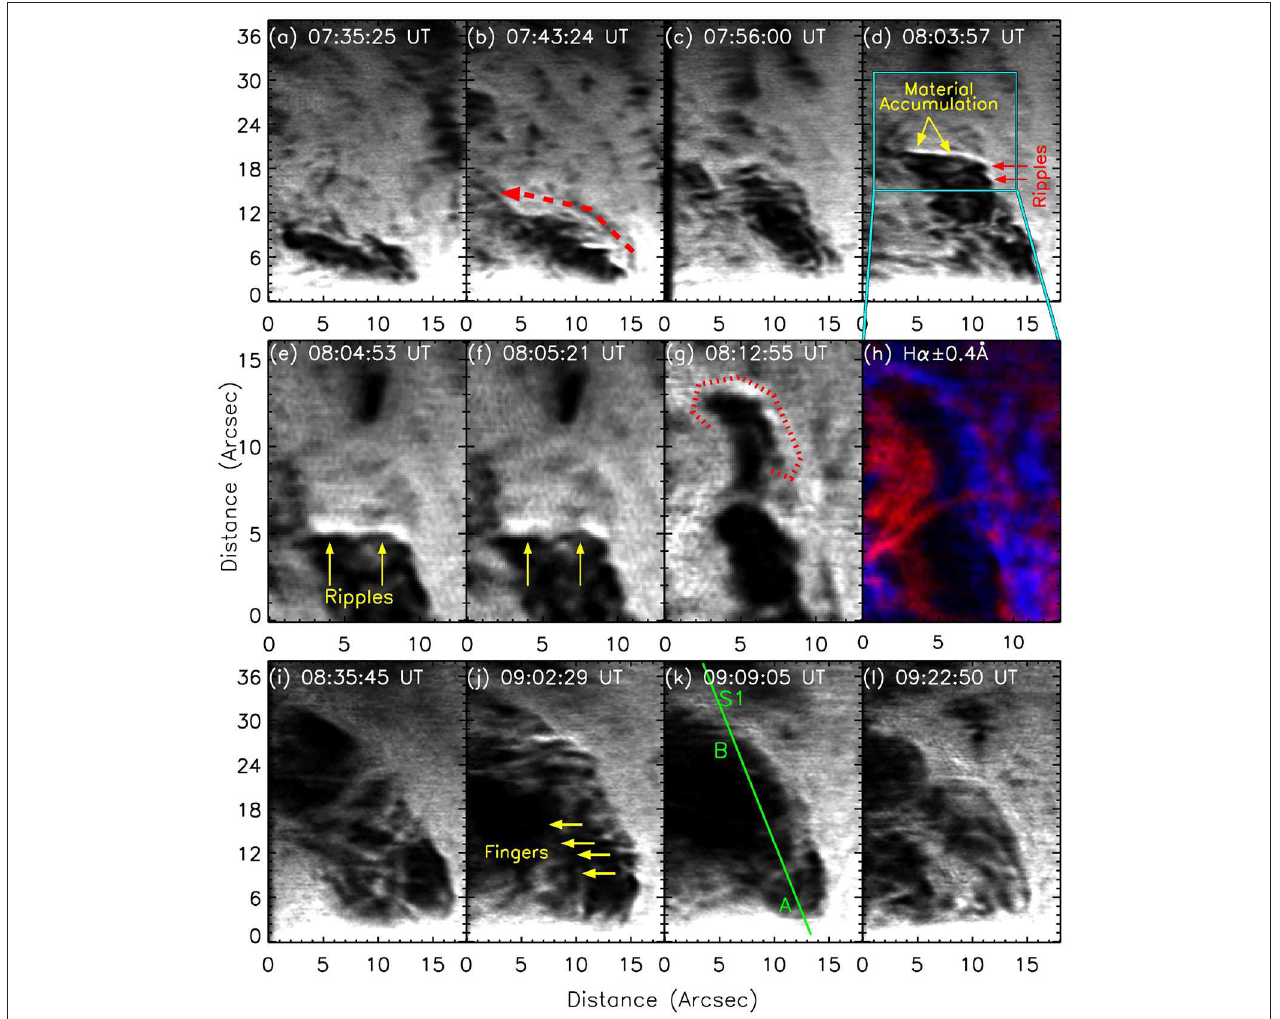
FIGURE 2 | Dynamical evolution of a prominence bubble since its formation as seen in the H α line-center and line-wing image sequence, acquired by NVST telescope. Crucial dynamical activities exhibited by the material flowing in the bubble interior and at the boundary include; anti-clockwise shear flow at the bubble boundary (a–b) , brightened section of the bubble boundary indicating the plasma accumulation as bubble uplifts (c–d) ; rippling boundary followed by the generation of a mushroom-head plume ( e–g in H α line-center). H α line-wing images of the plume show dissimilar line-of-sight flow pattern across the rising plume which comprises of blue-shifted material at the head of the plume while red-shifted material is predominant at its left leg (h) . A clear instance of the formation of finger-shaped structures, extending out from the right boundary of the bubble, is shown in (j) . Constantly altering mass distribution in the bubble interior (i–l) is indicative of the highly dynamical nature of the investigated bubble. ( A movie covering the entire evolutionary sequence of the bubble in the H α line-center as well as in the line-wings, and in various EUV wavelengths is made available online as a Supplementary Material